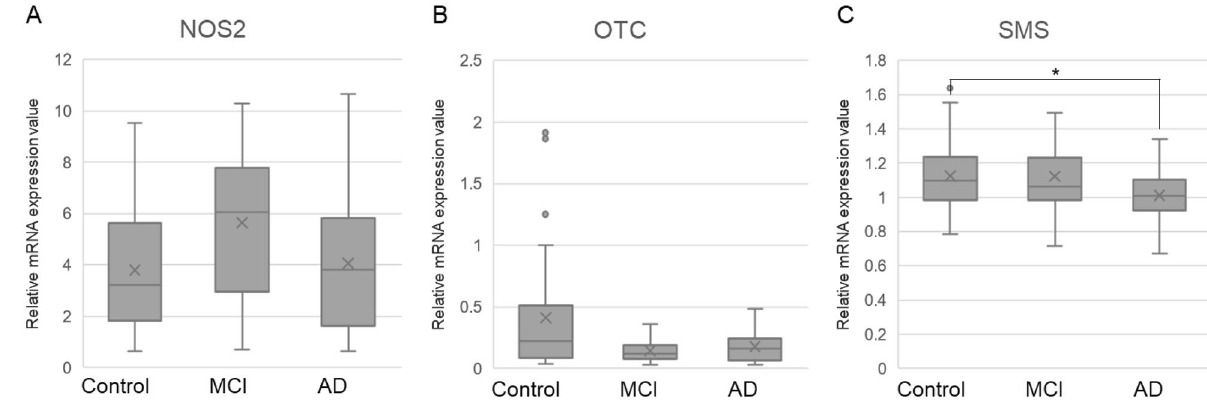
Figure 2. Comparisons of mRNA expression levels of metabolism enzymes for ( A ) NOS2, ( B ) OTC, and ( C ) SMS. * P < 0.05.